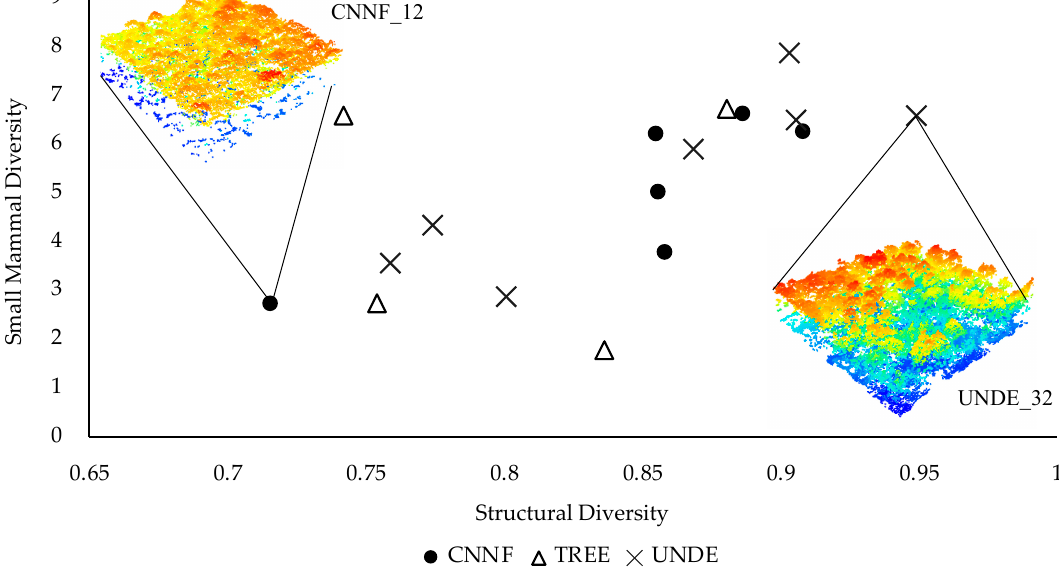
Figure 5. Relationship between plot-level small mammal diversity and structural diversity, classified by site, with example LiDAR point clouds for the lowest and highest structurally diverse plots.